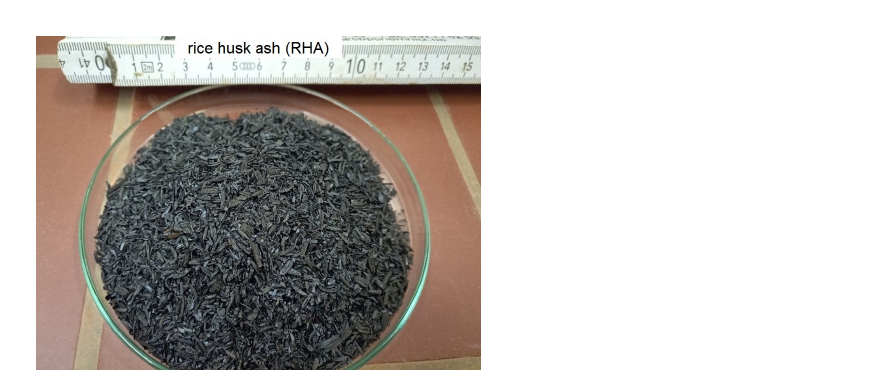
Figure 3. Potential secondary materials to substitute cement: rice husk ash (Figure source: Radek Kucera).